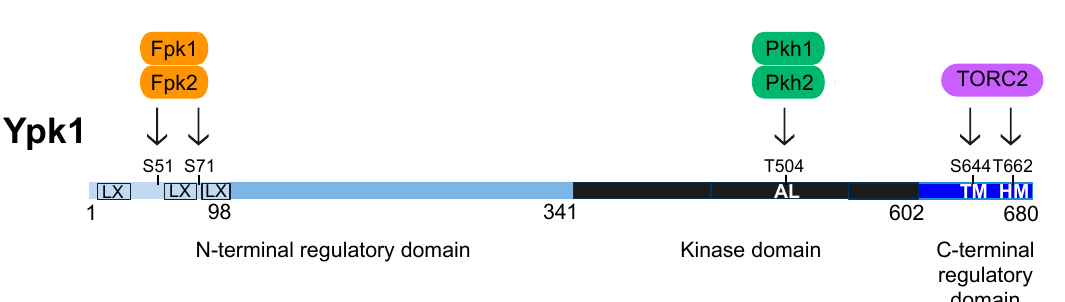
Figure 1. Schematic depiction of the primary structure of Ypk1. Catalytic domain (black) and N- (light blue) and C-terminal (dark blue) regulatory elements are indicated. Shading reflects percent sequence identity between Ypk1 (680 residues) and the corresponding segment in its paralog Ypk2 (677 residues): 1–98, 22% (faint blue); 99–341, 62% (medium blue); 342–602, 90% (black); and, 603–680, 73% (dark blue). Abbreviations: LX, low-complexity sequences predicted by UnitProt [50] and/or SMART [51] databases; AL, activation loop Thr (T504), phosphorylated by Pkh1 and, less efficiently, by Pkh2 [46]; TM, turn motif Ser (S644), phosphorylated by TORC2; and, HM, hydrophobic motif Thr (T662), phosphorylated by TORC2. Two N-terminal residues phosphorylated by Fpk1 and, less efficiently, by Fpk2 [52] are also shown.